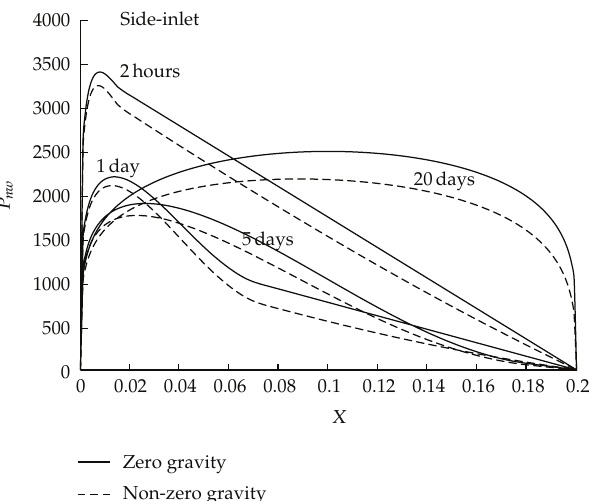
Figure 6: Comparison between considering and neglecting gravity e ff ect on oil pressure for the side-inlet case, at z (cid:8) 0 . 15m.